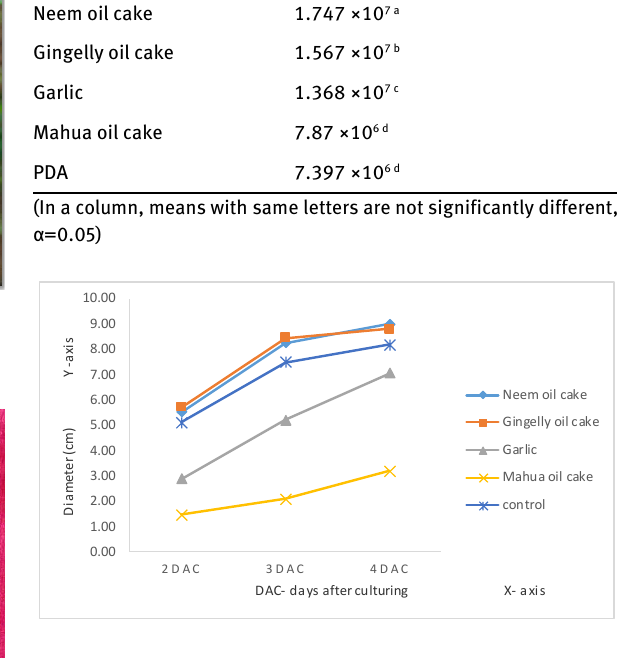
Figure 2: Mycelial growth rate of T. viride on different oil cakes and